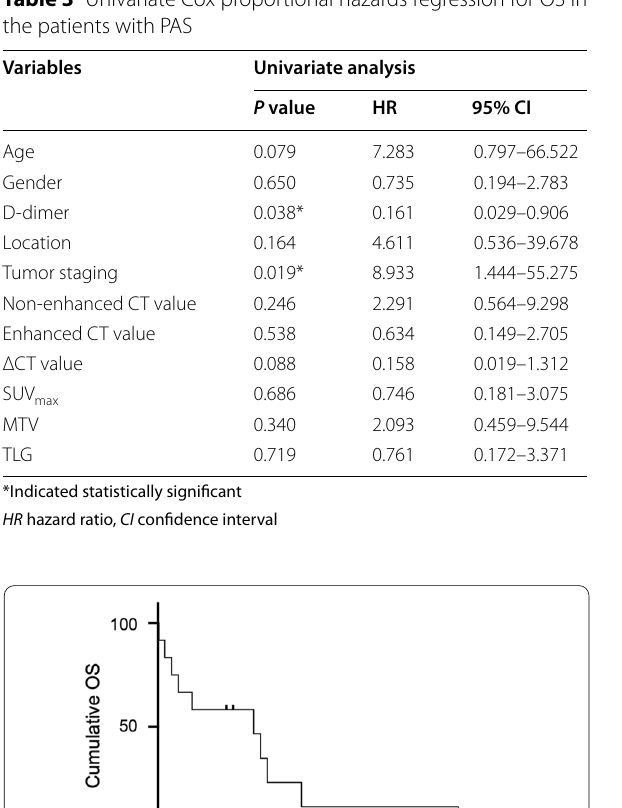
The follow-up duration was 11.8 ing from 0.2 to 44.0 months.